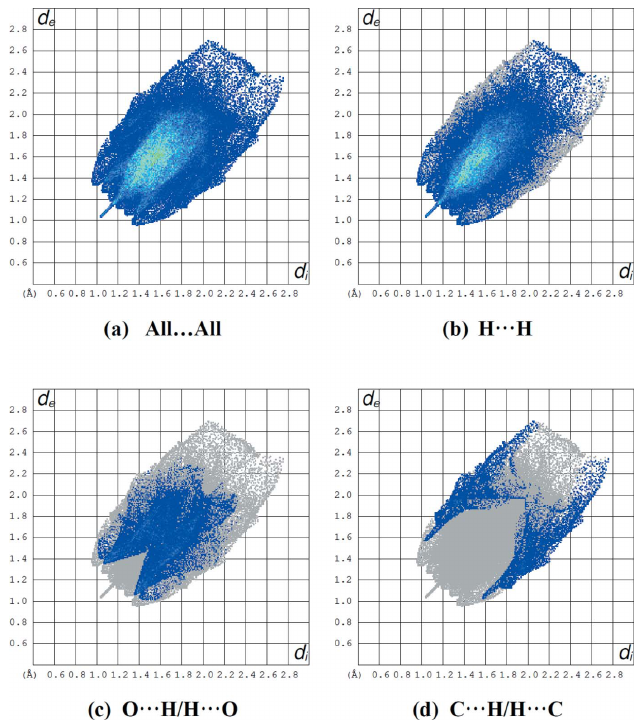
Figure 4 A view of the two-dimensional fingerprint plots for the title compound, showing ( a ) all interactions, and delineated into ( b ) H (cid:2)(cid:2)(cid:2) H, ( c ) O (cid:2)(cid:2)(cid:2) H/ H (cid:2)(cid:2)(cid:2) O and ( d ) C (cid:2)(cid:2)(cid:2) H/H (cid:2)(cid:2)(cid:2) C interactions. The d i and d e values are the closest internal and external distances (in A˚ ) from given points on the Hirshfeld surface.